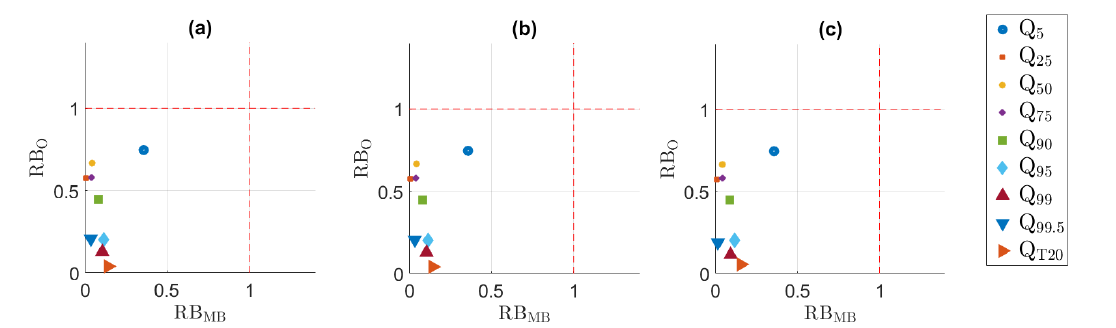
Figure 5. RB MB versus RB O for the discharge percentiles and the 20 year return period value. ( a ) QDM, ( b ) SSR & QDM, ( c ) TDA &